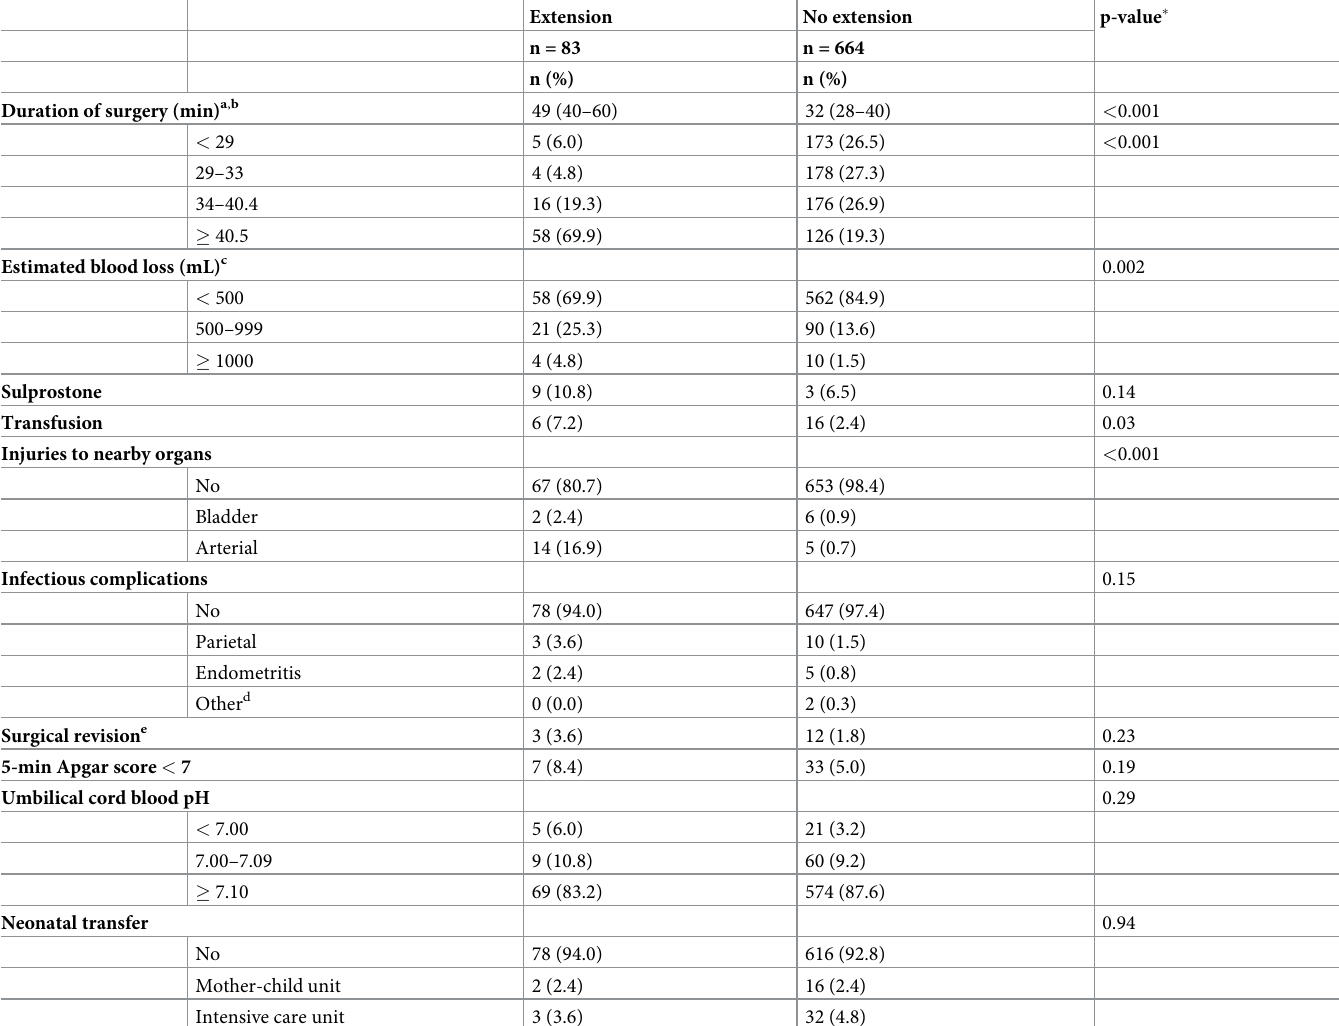
Table 5. Maternal and neonatal complications according to the occurrence of hysterotomy